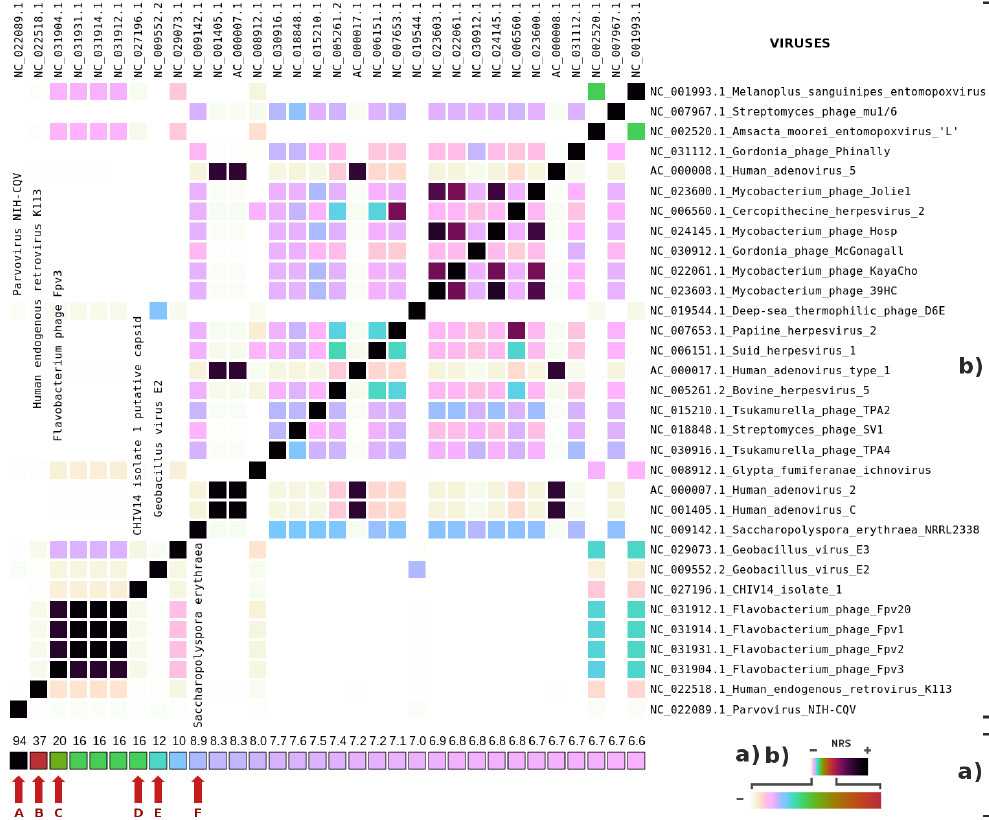
Figure 7. Metagenomic composition analysis of the PUM sample, specifically for viral genomes: ( a ) the percentage of the highest NRS entries in descending order (from left to right), according to the order of the names at the top; abd ( b ) the viral genome intra-similarities are based on the NRS. The names of the viruses and the sequence identifiers are both represented. Letters (in red) identify potential genomes contained in the